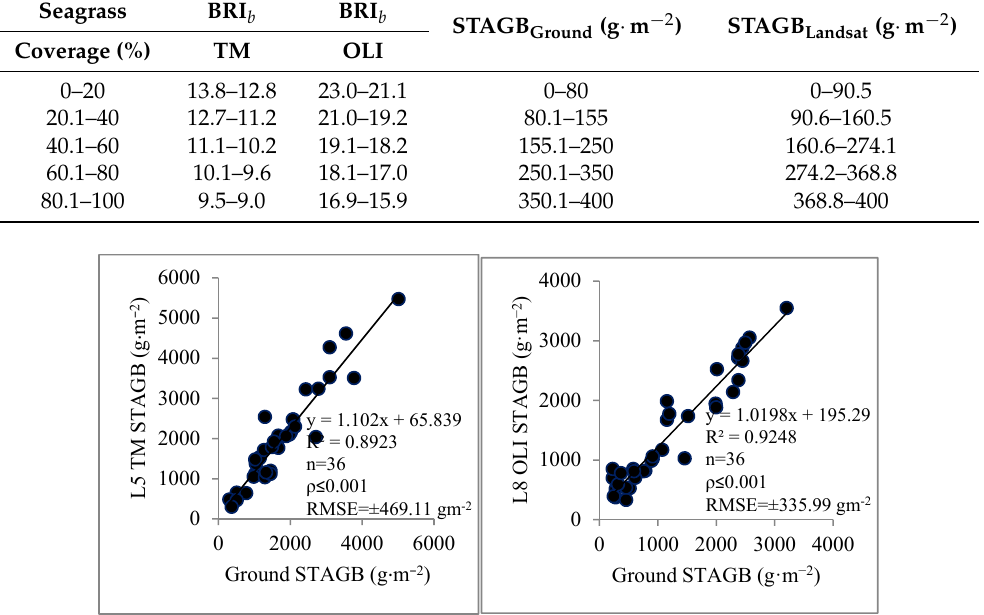
Table 11. Results of seagrass total aboveground biomass (STAGB) with respect to BRI range. Seagrass